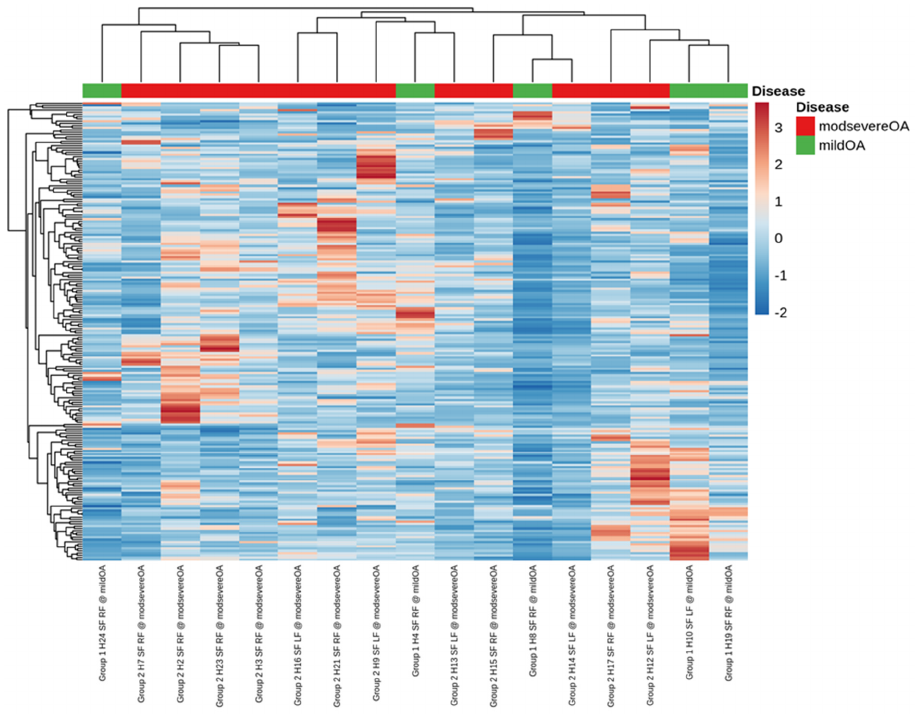
Figure 1. A visual representation of the data using a heatmap to identify patterns and relationships between the two groups as well as outliers. The analysis showed no outlying samples and largely overlapping miRNA profiles between the mild and severe osteoarthritis groups.